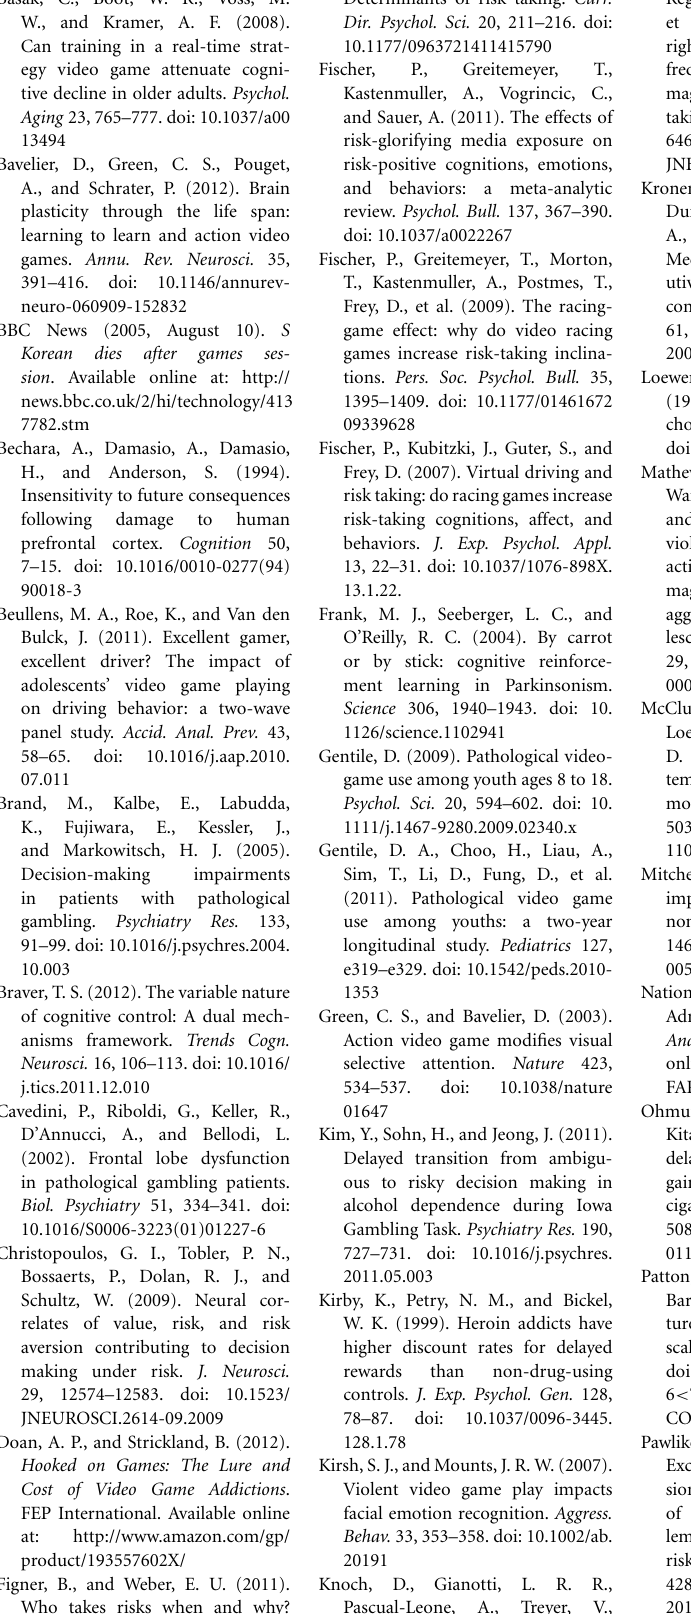
Figner, B., and Weber, E. U. (2011). Who takes risks when and